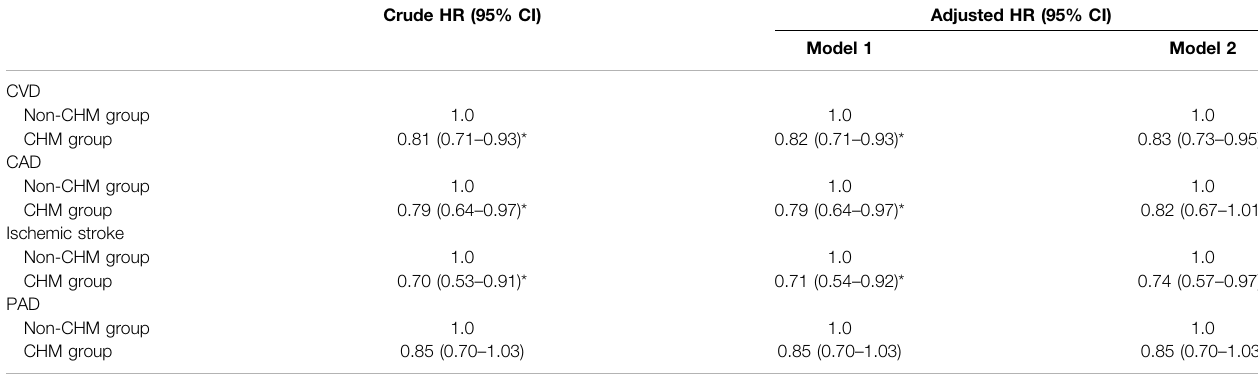
TABLE 3 | Hazard ratios of cardiovascular disease in systemic lupus erythematosus patients treated with and without Chinese herbal